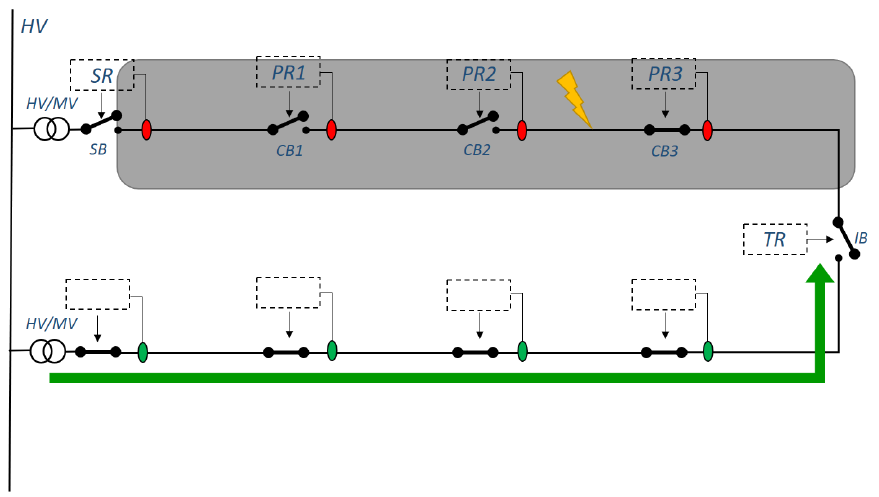
Figure 22. Management of a fault between PR2 and PR3 when a connection problem